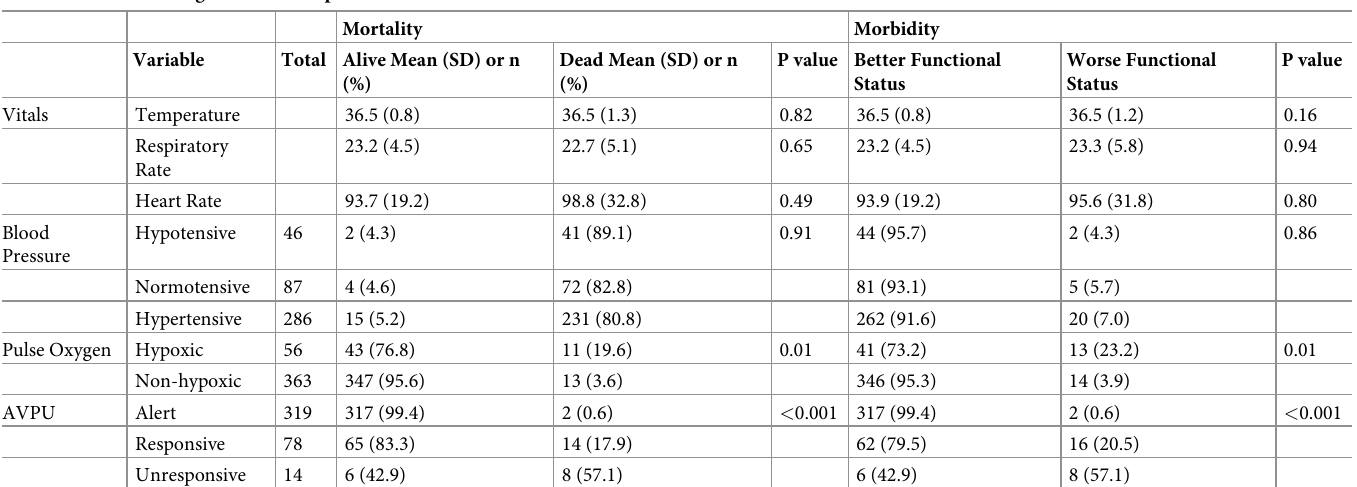
Table 3. Patient vital signs and overall